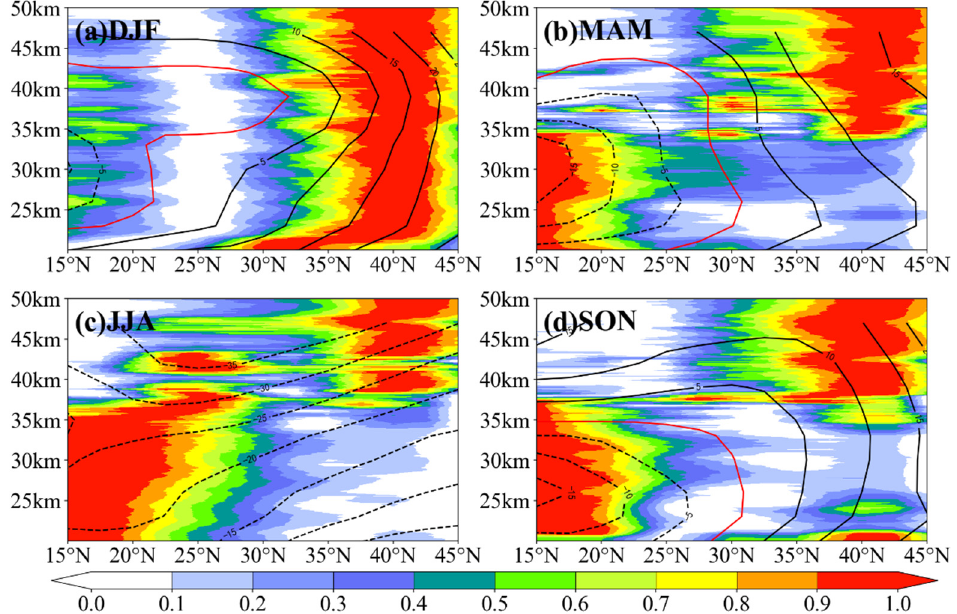
Figure 6. Latitude–height distribution of normalized Ep (shaded) and zonal westerly (solid lines, unit: m s − 1 ) and easterly (dashed lines, unit: m s − 1 ) winds along the seasonal mean of 107.5° E (±7.5°). ( a ) DJF, ( b ) MAM, ( c ) JJA, and ( d ) SON.